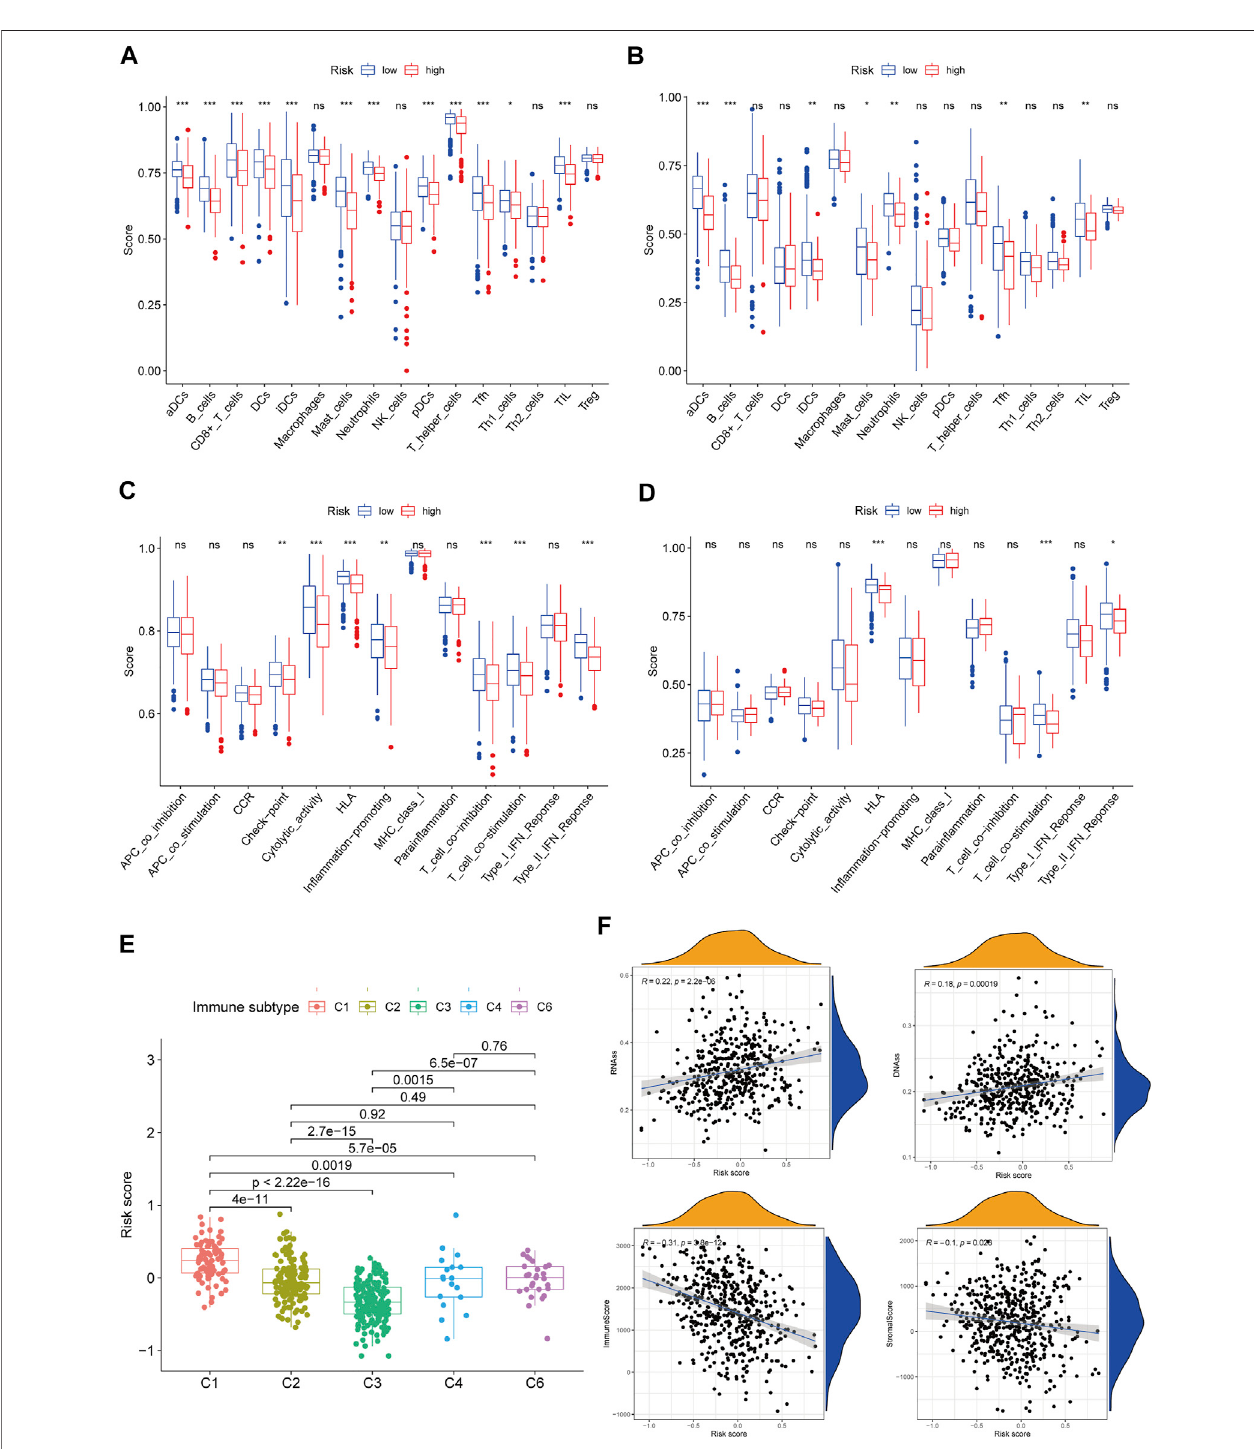
FIGURE 6 | Immune status between different risk groups and the association between risk score and tumor microenvironment. TCGA cohort (A,C) , GEO cohort (B,D) . (A,B) The scores of 16 immune cells and (C,D) 13 immune-related functions were showed in boxplots. (E) Comparison of the risk score in different immune in fi ltration subtypes. (F) The relationship between risk score and RNAss, DNAss, Stromal Score and Immune Score. p values were showed as: ns, not signi fi cant; * p < 0.05; ** p < 0.01; *** p < 0.001.